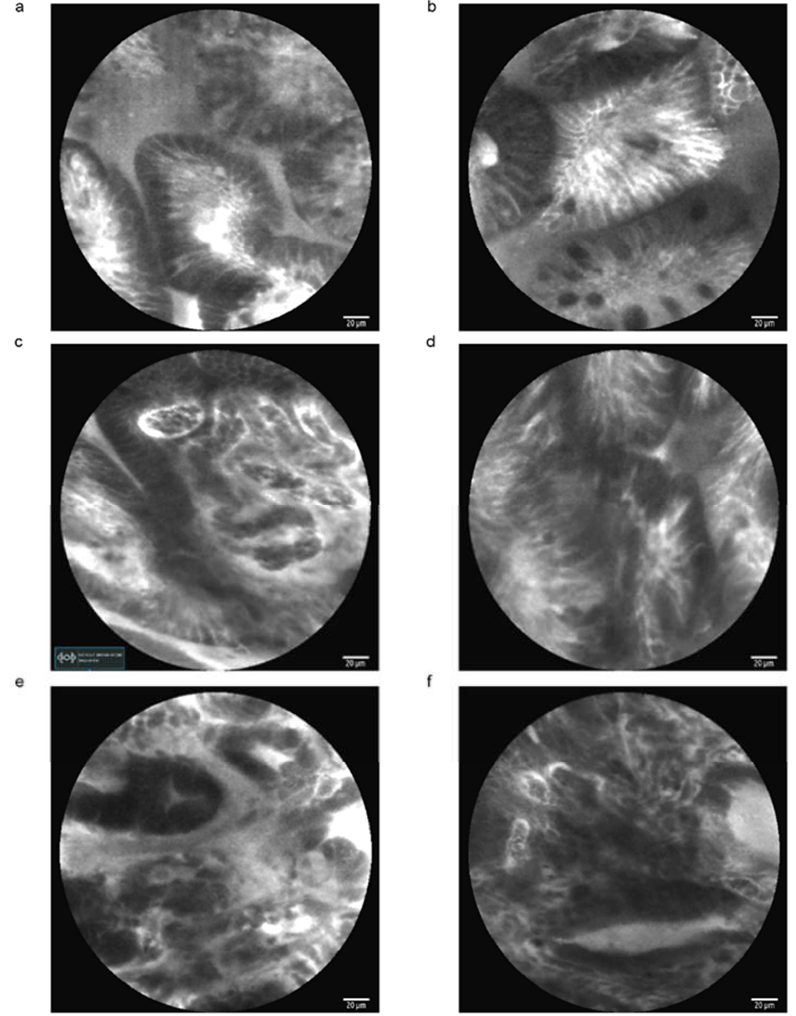
Figure 2. Examples of CLE images in the human stomach. CLE showed glandular atrophy with decreased gastric pits and markedly dilated opening ( a ). CLE showed gastric intestinal metaplasia with dark goblet cells within the columnar epithelium ( b ). CLE showed high-grade intraepithelial neoplasia with distorted pits and irregular epithelial lining in cardia of the stomach ( c – d ). CLE showed moderately differentiated adenocarcinoma with atypical/naive glands and dark epithelium ( e – f ).